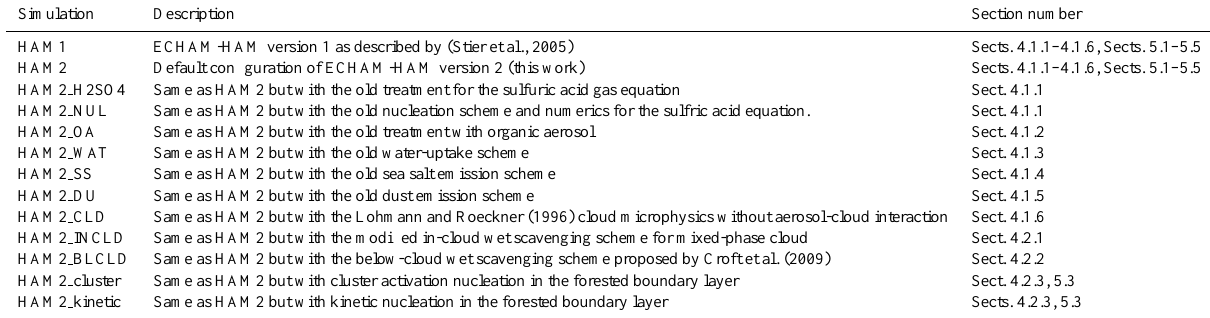
Table 4. List of simulations presented in this paper.